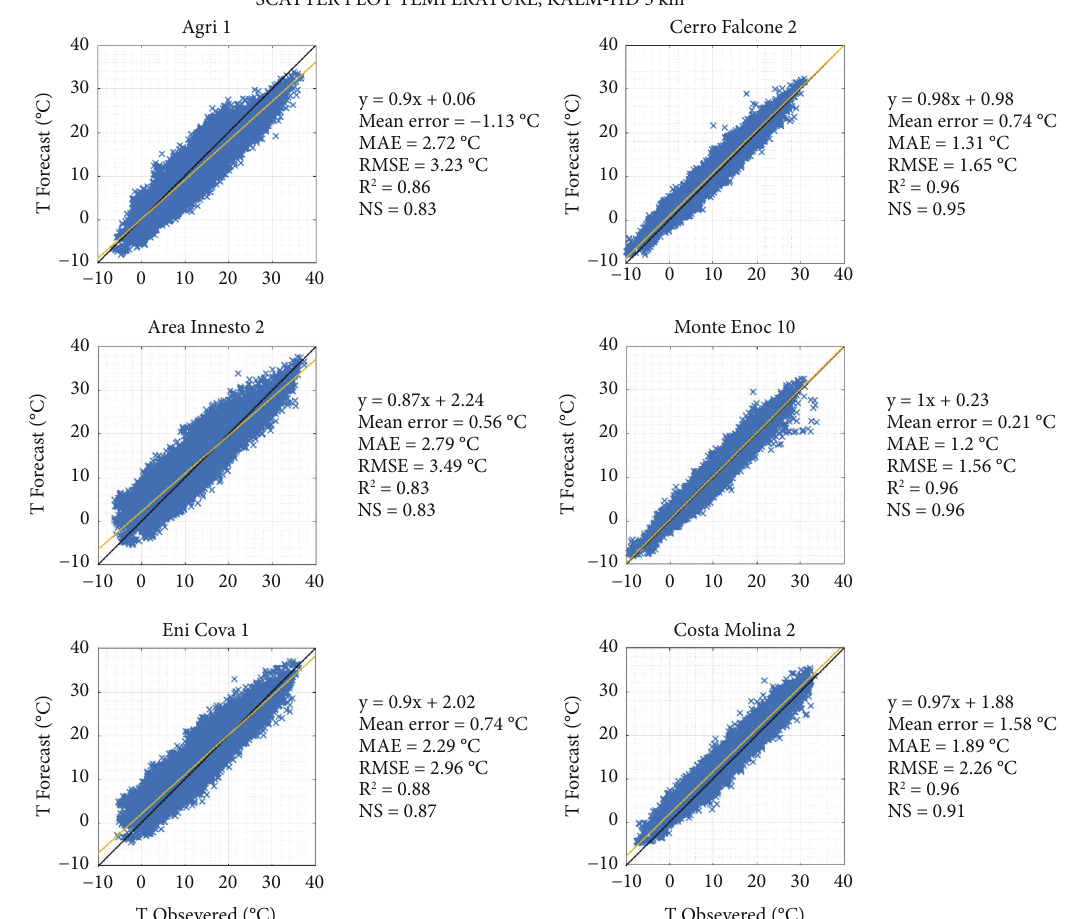
Figure 7: Scatter plots of the KALM-HD model with 5km as grid resolution vs. observed data for the hourly temperature forecast over the six stations at day +1 as lead time for the whole two years of the observation period. On the left are the “valley stations,” and on the right are the “mountain